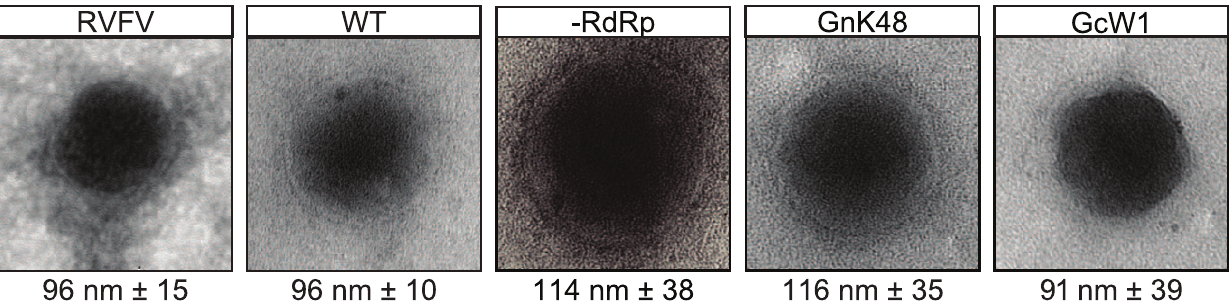
Figure 1. RVFV and RVF-VLPs have similar morphology. RVFV and RVF-VLPs were harvested by ultracentrifugation and analyzed by transmission electron microscopy with negative staining. The particle sizes were measured, and the values listed are the mean sizes of particles with